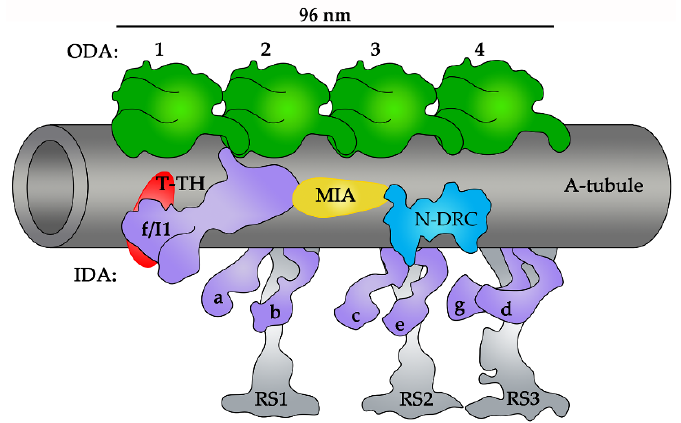
Figure 4. A schematic representation of the 96 nm axonemal unit with the position of the modifier of inner arms (MIA) complex (in yellow) and tether/tether head (T/TH) complex (in red) indicated. ODAs (outer dynein arms, in green), IDAs (inner dynein arms, in violet), RSs (radial spokes, in grey), N-DRC (nexin–dynein regulatory complex, in blue) [4,118,151–153].